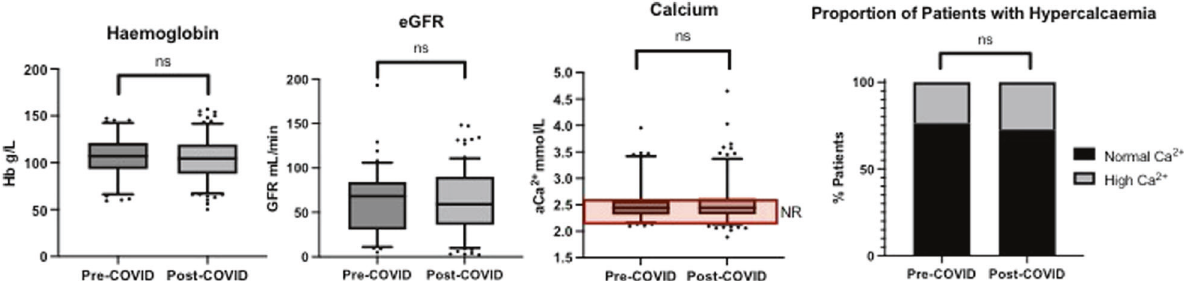
Fig. 1 Presenting pathological features of symptomatic, newly-diagnosed myeloma patients. Those diagnosed between 1st January 2019 – 31st January 2020 (Pre-COVID, n = 93) and those diagnosed from 1st February 2020 – 31st July 2021 (Post-COVID, n = 172). Data presented as box plots of 95% con fi dence intervals. * p < 0.05, ns non-signi fi cant, NR normal range.